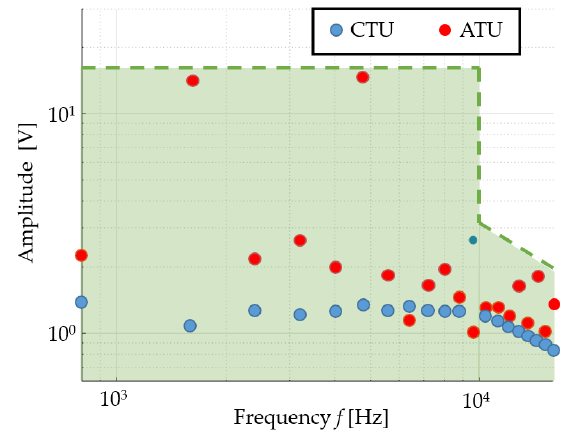
Figure 10. ATU input current